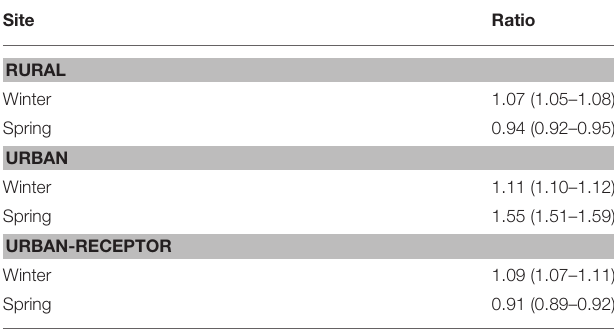
TABLE 6 | Ratio between measured ammonium and predicted